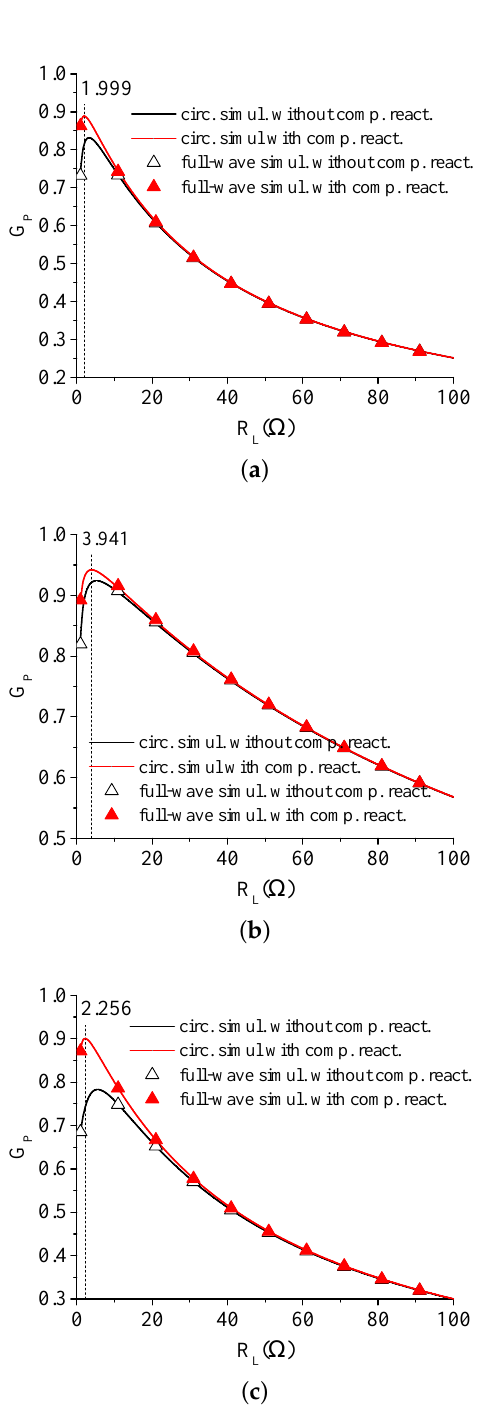
Figure 7. Power gain calculated through circuital simulations by varying the resistive part of the loads R Ln . ( a ) Case 1, the link has two receivers with R L 1 = R L 2 = R L ; ( b ) Case 2, the link has three receivers with R L 1 = R L 2 = R L 3 = R L ; ( c ) case 3, the link has four receivers with R L 1 = R L 2 = R L 3 = R L 4 = R L